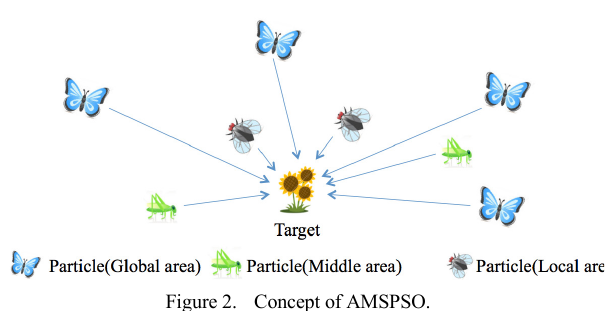
Figure 2. Concept of